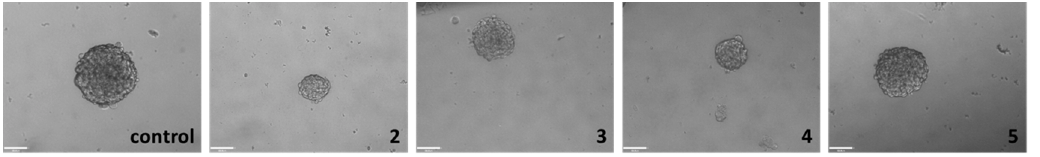
Figure 3. Bright ‐ field images (taken using an inverted microscope) representative of untreated HMLER ‐ shEcad mam ‐ mospheres and those treated with 2 – 5 for 5 days at their respective IC 20 values. Scale bar = 100 μ m.